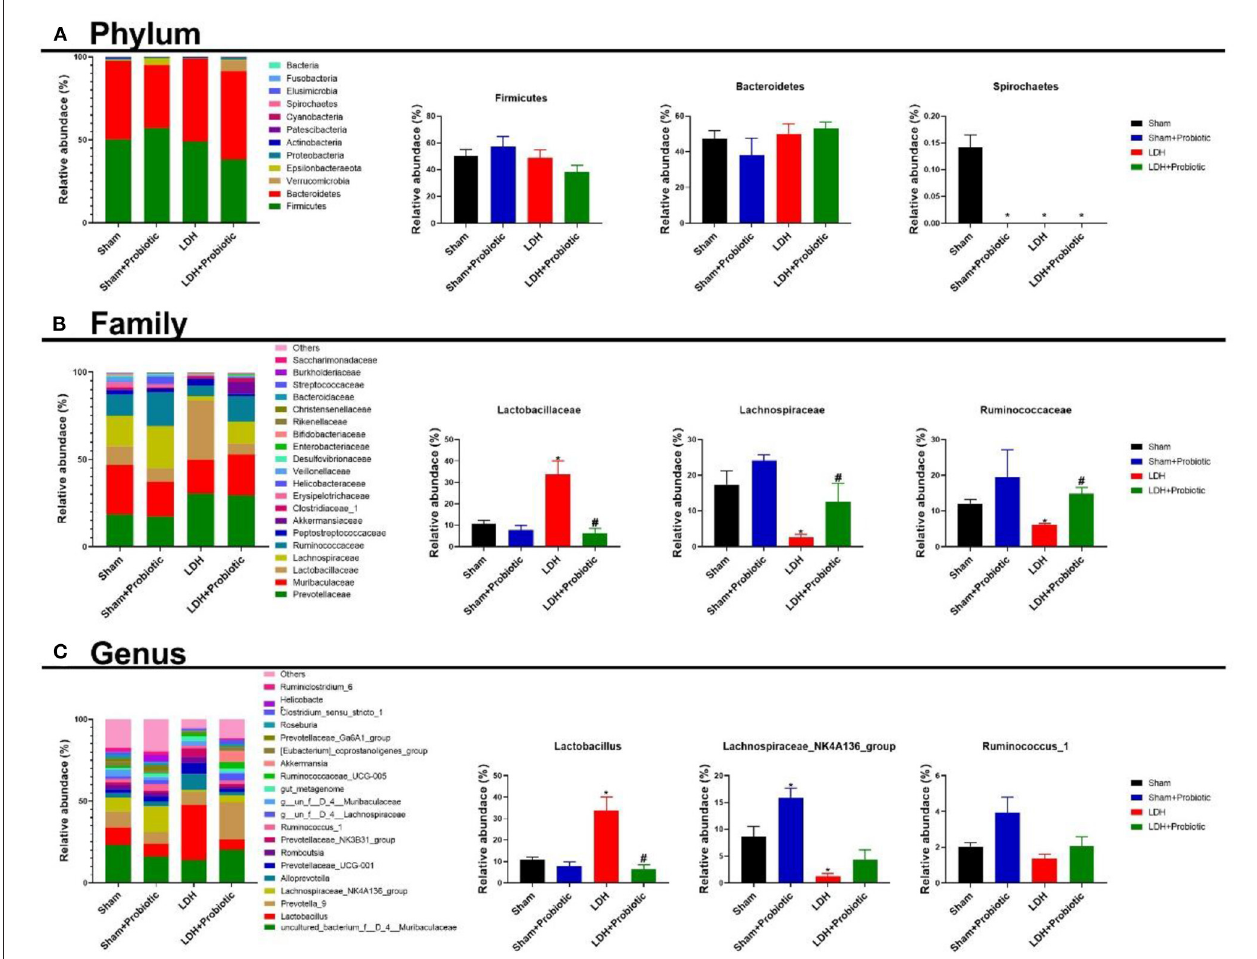
FIGURE 5 | Fecal microbial composition. (A) Phylum level; (B) Family level; (C) Genus level. Data were expressed as the mean ± SEM. * P < 0.05 vs. Sham; # P < 0.05 vs.